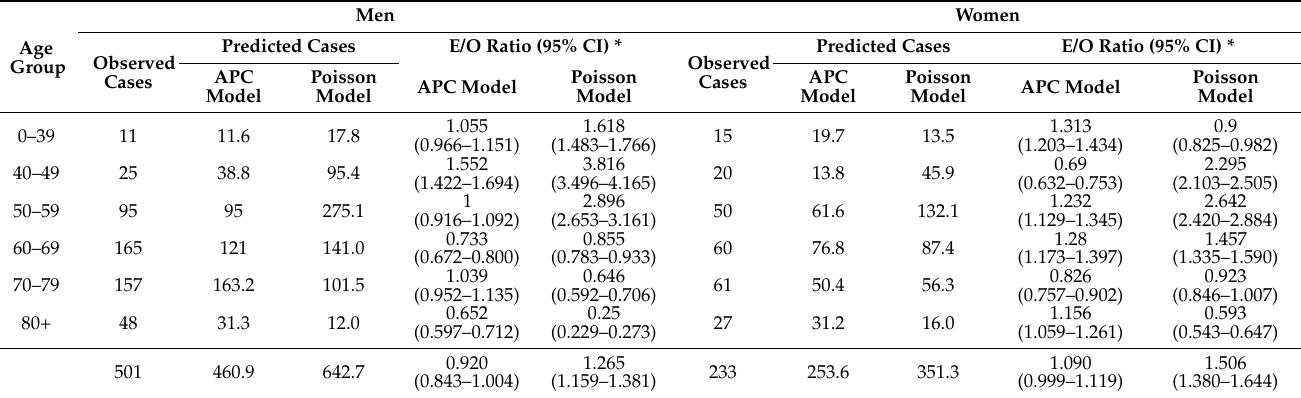
Table 2. Comparison by age group (years) of malignant mesothelioma cases predicted using the APC model and Poisson regression model with observed cases during the 2014–2018 period.